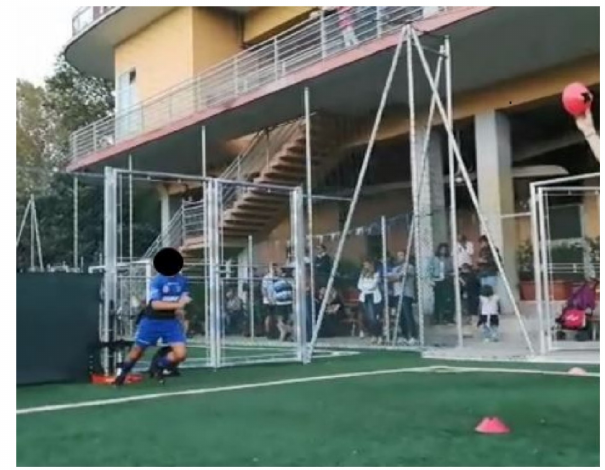
Figure 1. The isoinertial device application on the athlete exercises in the intervention